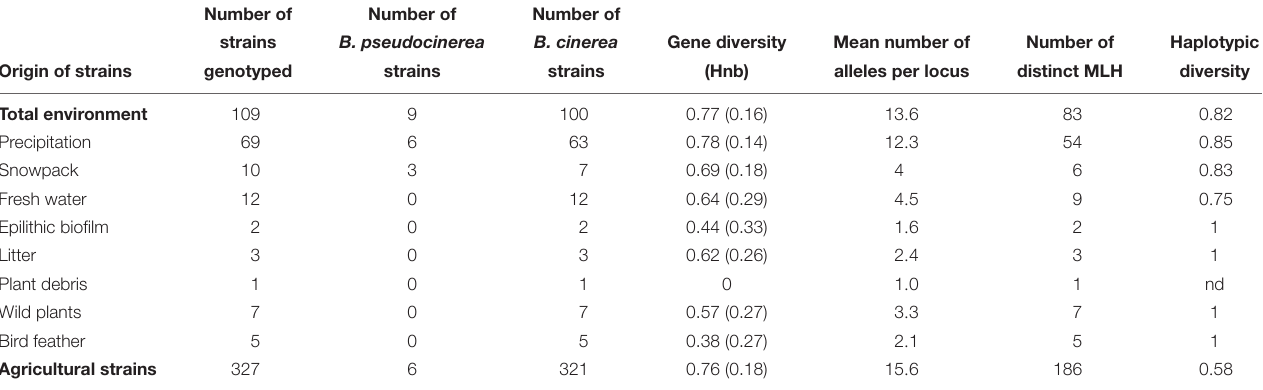
TABLE 2 | Indices of genetic diversity among strains collected from non-agricultural habitats (environmental strains) and from crops (agricultural strains). Number of Number of Number of strains B. pseudocinerea